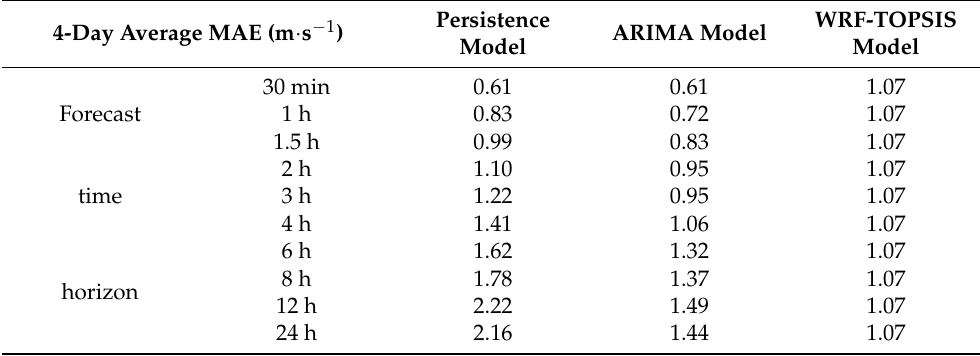
Table 8. Four-day average mean absolute error for the wind speed forecasting using the persistence, ARIMA, and WRF-TOPSIS models applied to the 4-day test dataset.